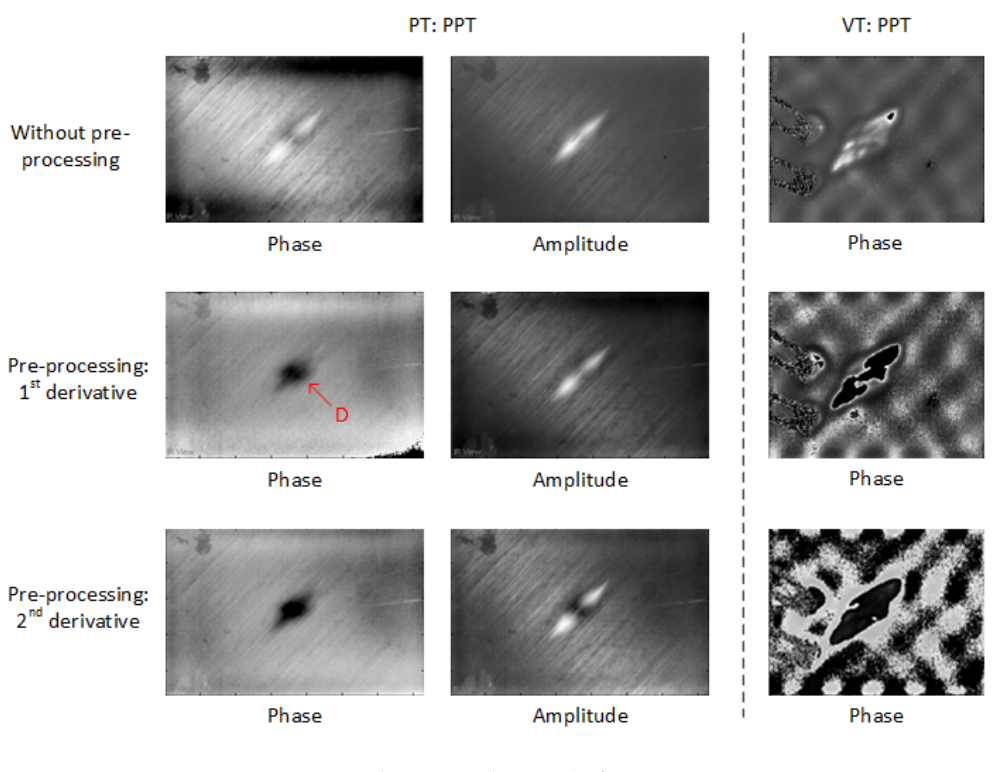
Figure 11. Thermographic results for CFRP 02.